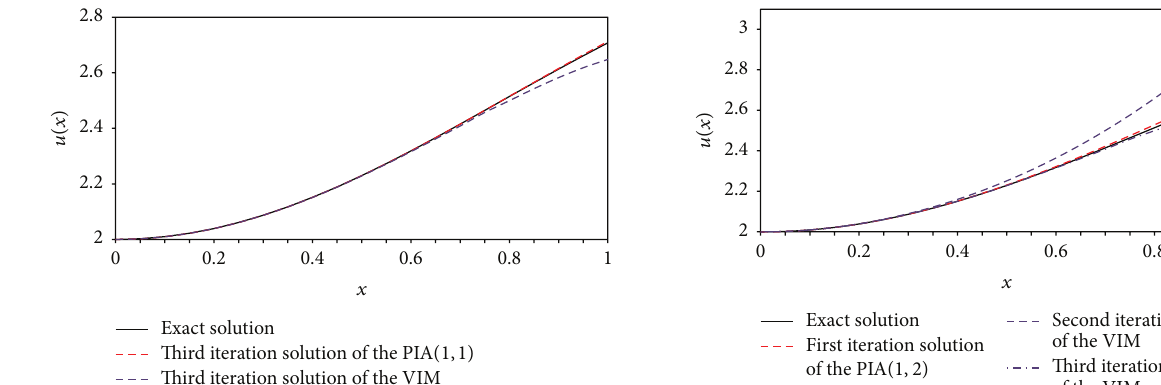
Figure 4: The comparison of second and third iteration solutions of the VIM and first iteration solution of the PIA (1,2) with exact solution of example